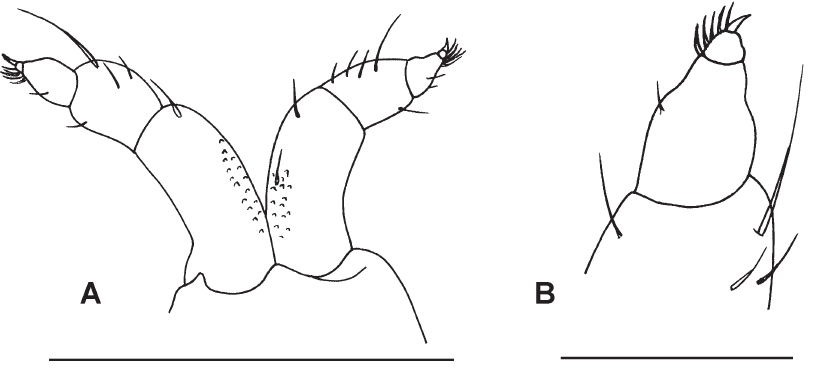
Fig. 6. Koiulus interruptus gen. et sp. nov., paratype, ♂, from the environs of the village of Zolotoi, seventh pair of legs. A . Ventral view. B . Tip of the telopodite. Scale bars: A = 0.5 mm; B = 0.1